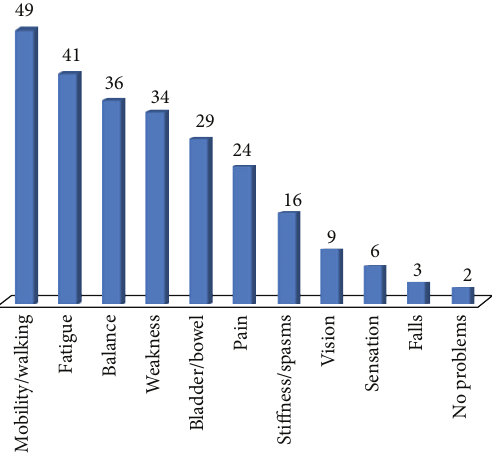
Figure 2: Main problems reported by